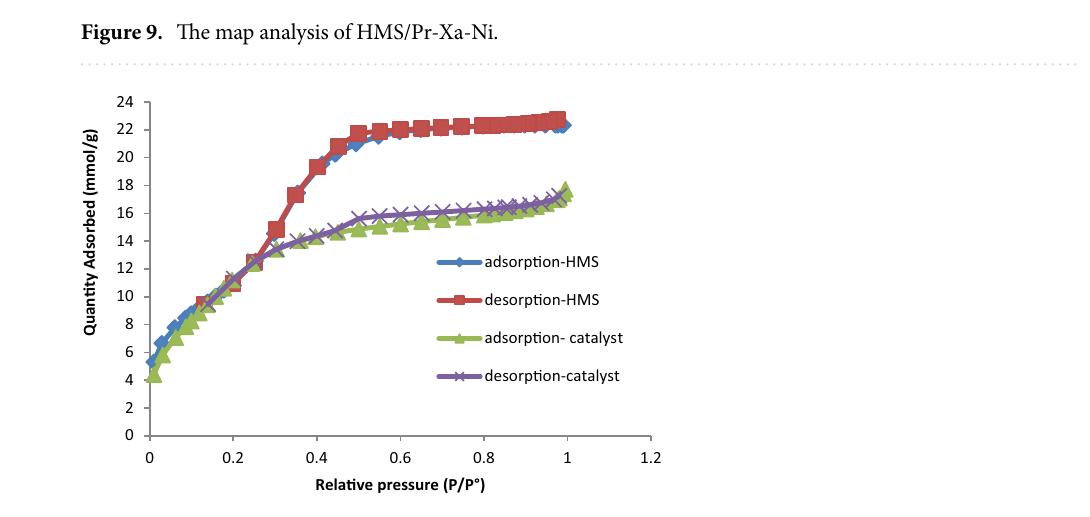
Figure 10. The N 2 adsorption–desorption isotherm for HMS and HMS/Pr-Xa-Ni.